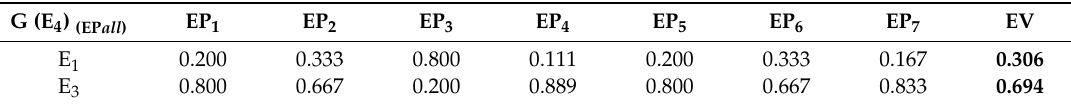
Table 7. Integrated EV values of E 1 and E 3 of the expert group targeting the interior interdependences of E 1